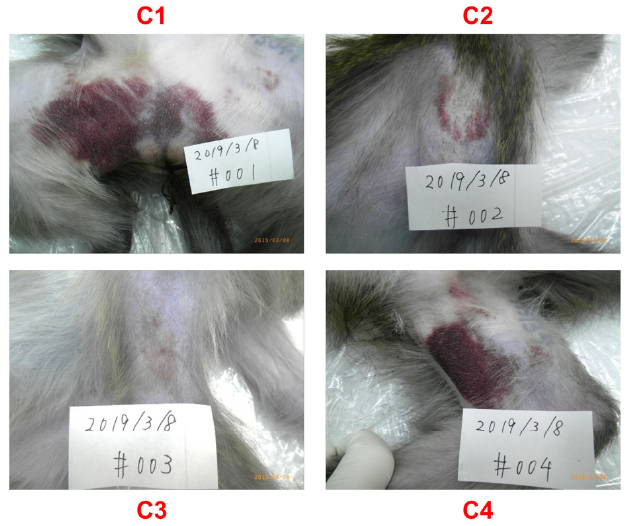
Figure 4. Change in the skin in ZIKV-infected monkeys. A change in the skin of group C (control) was observed. C1 – C4 denotes each animal ID in group C. ZIKV, Zika virus.